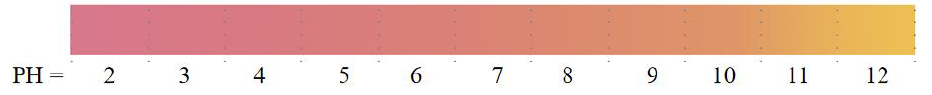
Figure 4. Color change of packaging film under different pH conditions [118].